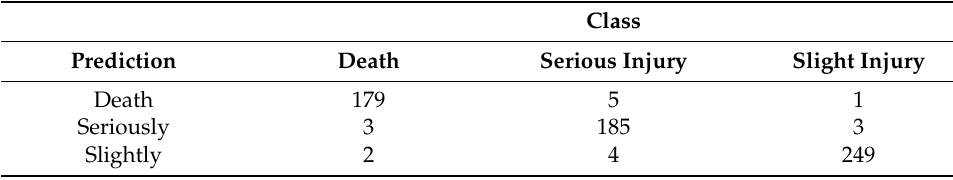
Table 7. Confusion matrix for the boosting tree model.